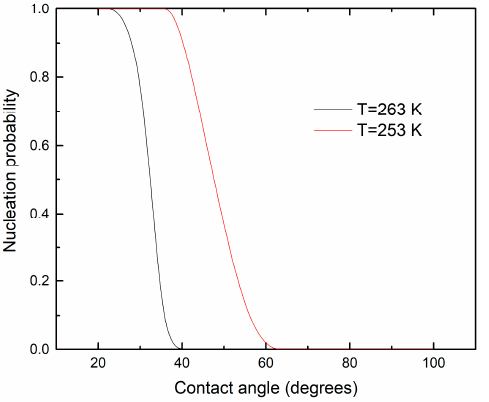
Figure 6. Ice nucleation probability versus contact angle of Pseudomonas syringae bacteria (r p = 0.3 µ m) at ambient temperatures of 263 K and 253 K.